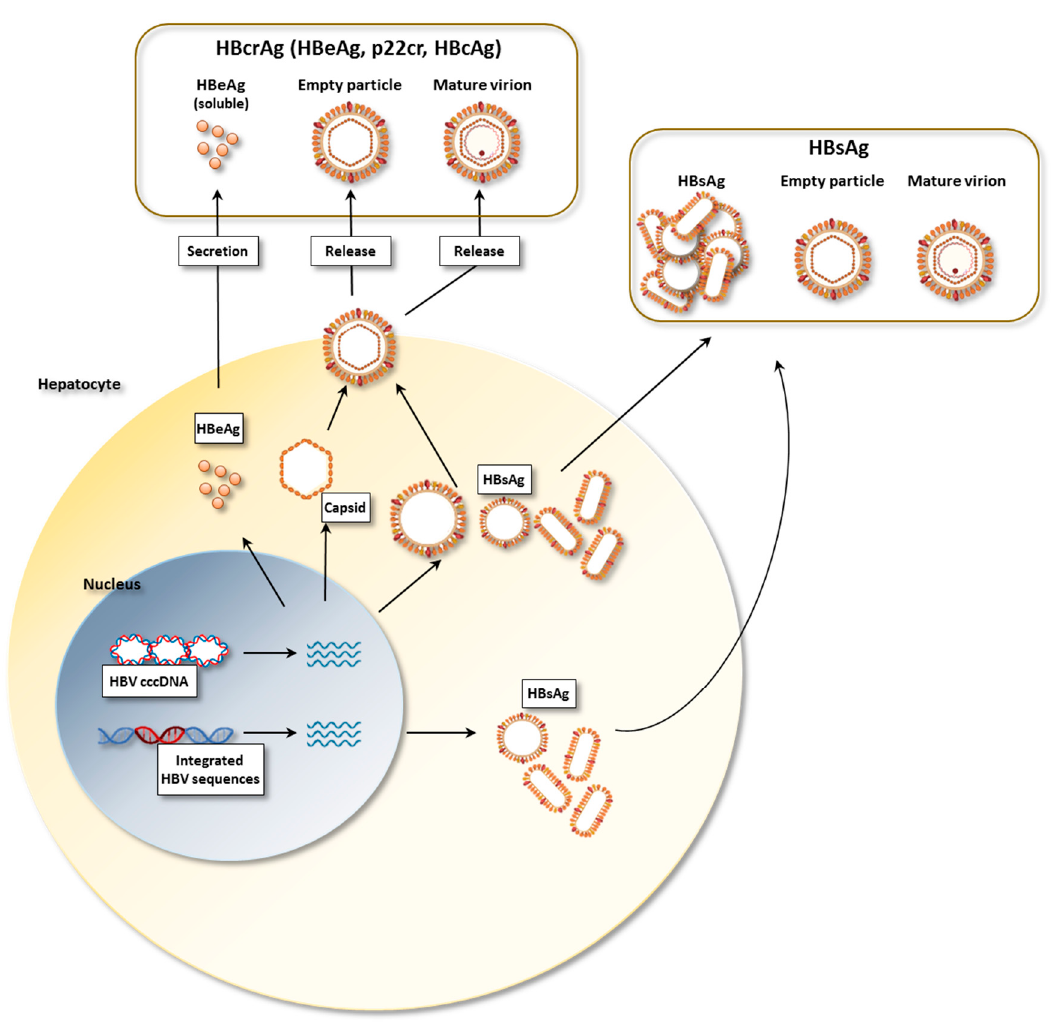
Figure 1. Schematic representation of HBsAg and HBcrAg production from the HBV-infected hepato- cyte. Created with: BioRender.com (accessed on 20 May